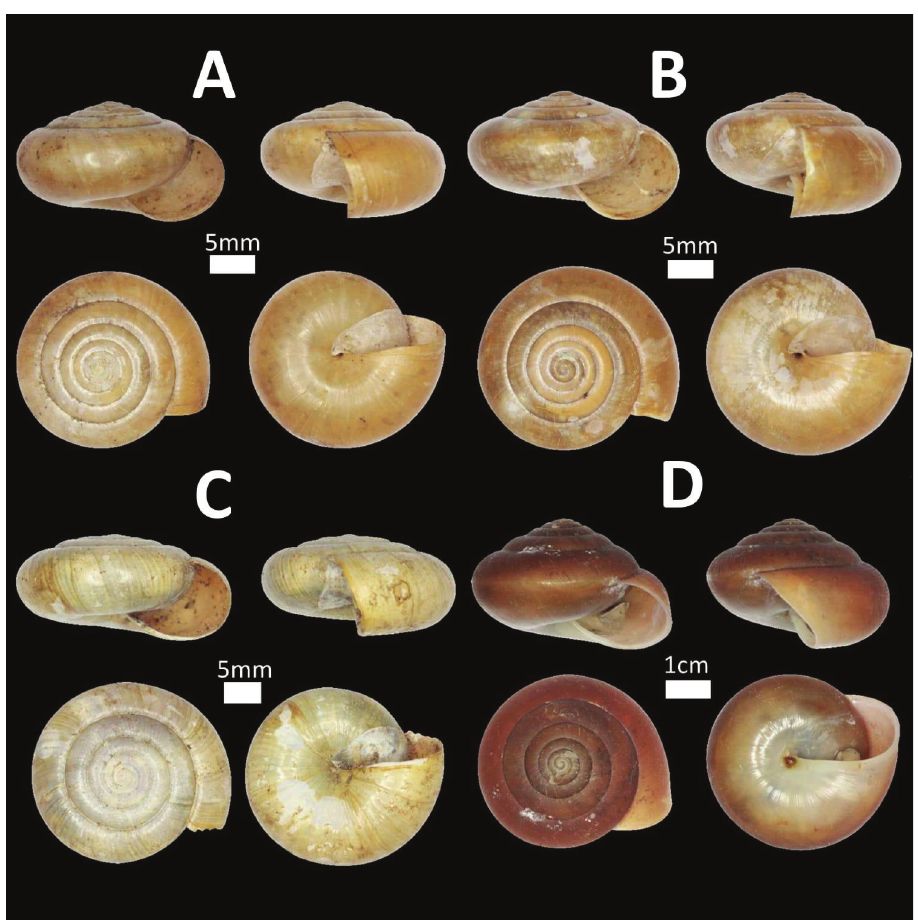
Figure 16. Family Dyakiidae. A Everettia jucunda (BOR/MOL 8419) B Everettia subconsul (BOR/MOL